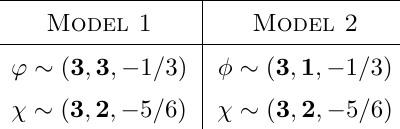
Table 3. Particle content of two key radiative models identi(cid:12)ed by ref. [64]. The tuple entries refer to transformation properties under SU(3) C (cid:10) SU(2) L (cid:10) U(1) Y , and here we adopt the hypercharge convention Q = I 3 + Y